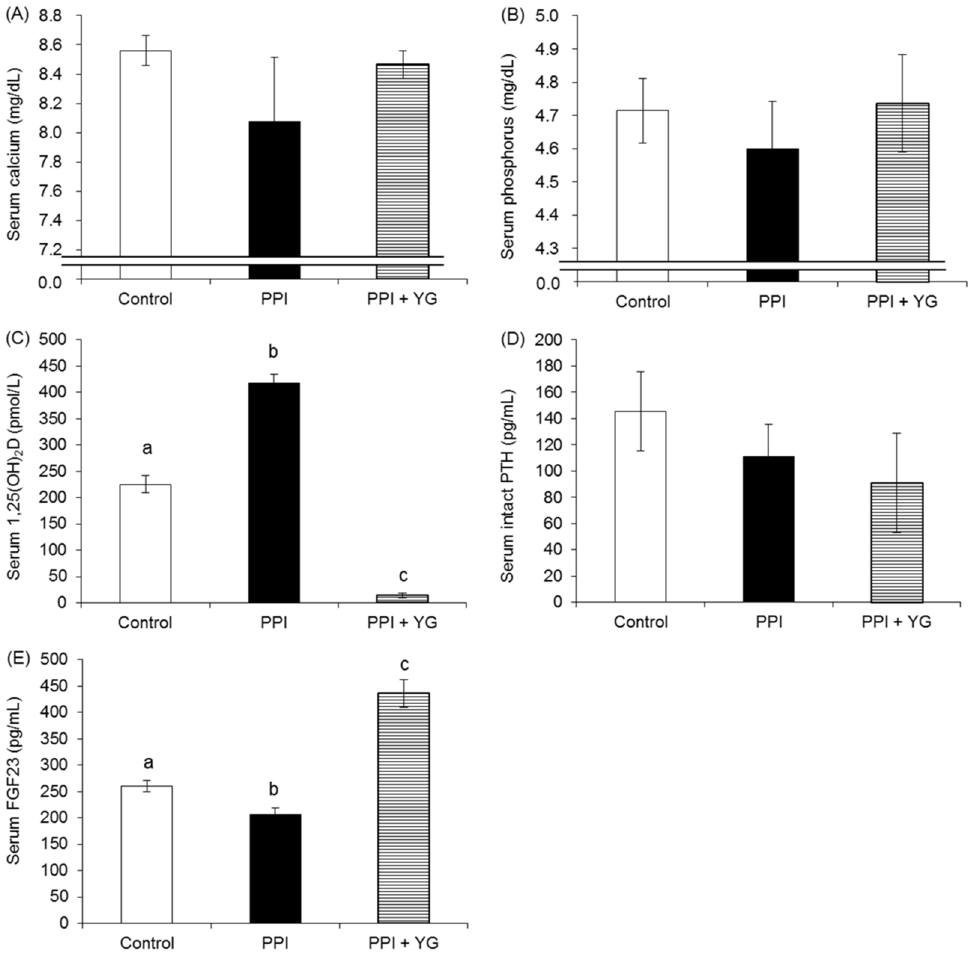
Figure 3. Effects of proton pump inhibitor (PPI) administration and the intake of a combination of yogurt and galactooligosaccharides (YG) on biochemical factors in adult rats. ( A ) Serum calcium levels; ( B ) Serum phosphorus levels; ( C ) Serum 1,25(OH) 2 D levels; ( D ) Serum intact parathyroid hormone (PTH) levels; ( E ) Serum FGF23 levels. Values are presented as the mean ± SE. a, b, c: bars with different letters are significantly different ( p < 0.05).